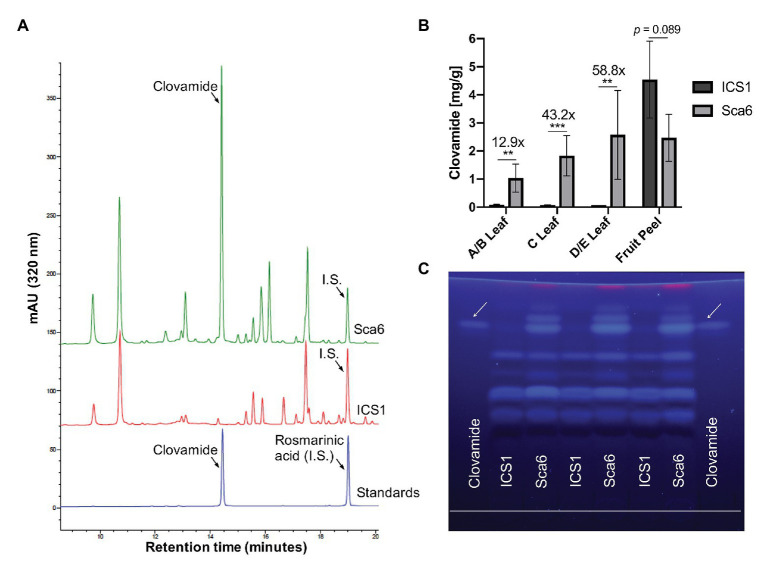
Clovamide detection and quantification in cacao leaf and fruit peel. (A) High performance liquid chromatography – diode array detector (HPLC-DAD, 320 nm) chromatogram of ‘Sca6’ and ‘ICS1’ stage C leaf extracts, including UV absorbance spectra for peaks of interest. I.S. = internal standard. (B) Clovamide content (mg/gram tissue) from HPLC-DAD. **
p < 0.01, ***
p < 0.001, t-test (n = 5 for leaves, n = 3 for fruit peel). Error bars represent standard deviation. (C) Thin-layer Chromatography (TLC) plate with clovamide standard and stage C leaf extracts from ‘ICS1’ and ‘Sca6’. White line drawn near bottom of plate is origin of sample loading. Photograph taken under 365 nm UV excitation.